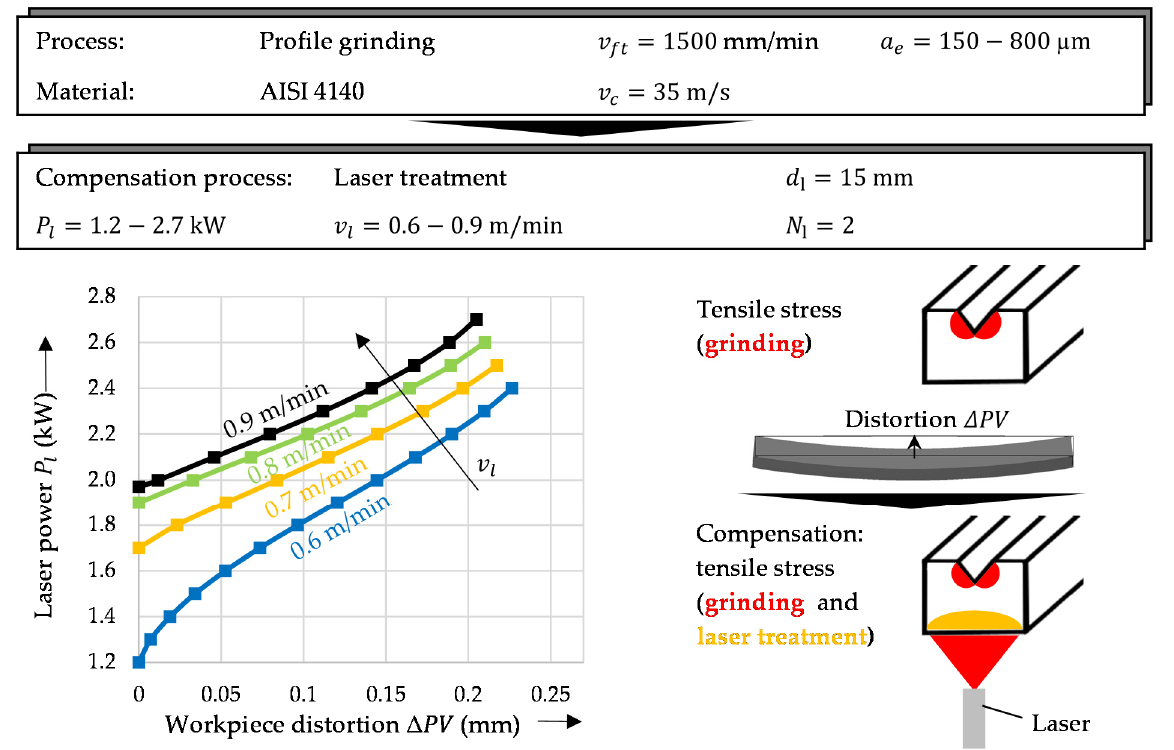
Figure 7. Distortion compensation strategy by multi-pass laser treatment with different laser powers P l and laser feed rates v l (optimal parameters) for workpieces ground with a constant feed rate of 1500 mm/min and depths of cut between 150 and 800 μ m.